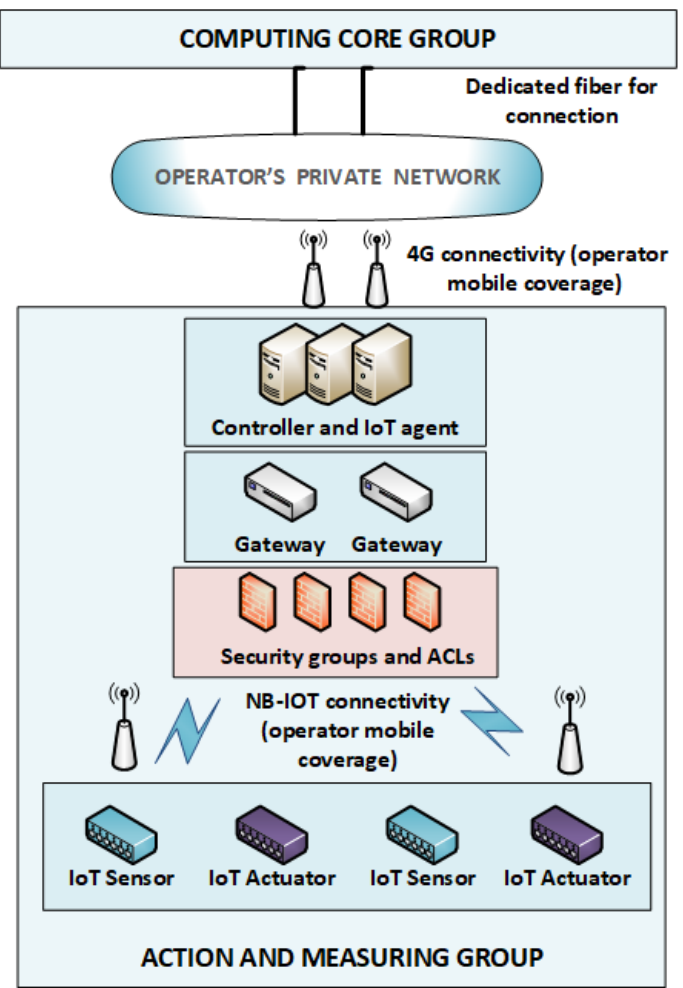
Figure 2. Action and measuring group